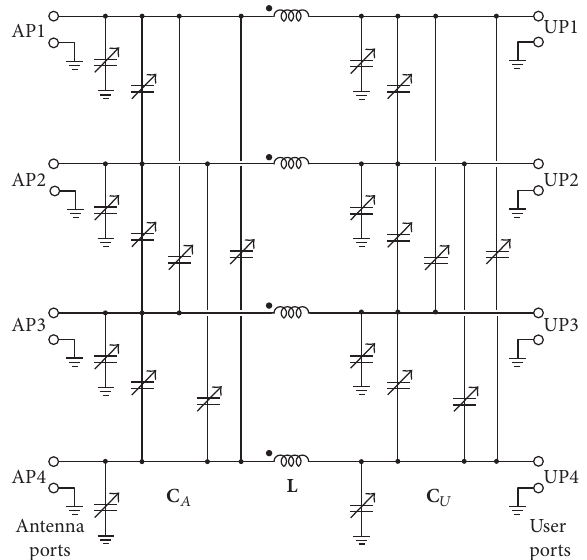
Figure 2: The MAPMUP antenna tuner having the structure of a multidimensional 𝜋 -network, in a configuration having 𝑛 = 4 antenna ports, labeled AP1 to AP4, and 𝑚 = 4 user ports, labeled UP1 to UP4.